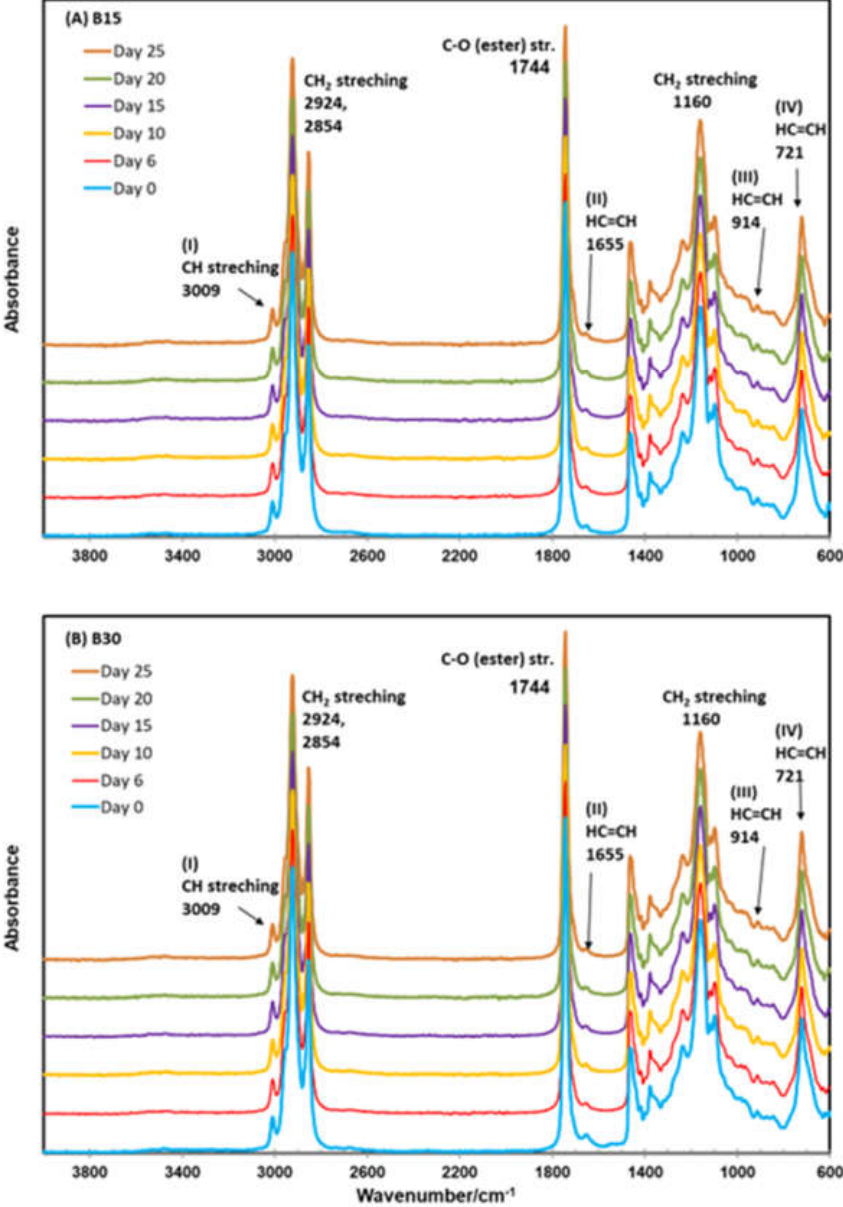
Figure 2. ATR–FTIR spectra of oil extracts of cottonseed butters over the accelerated oxidation storage for 25 days at 60 ◦ C. ( A ) B15 and ( B ) B30 are butter products made from the cottonseed roasted at 150 ◦ C for 15 and 30 min, respectively.